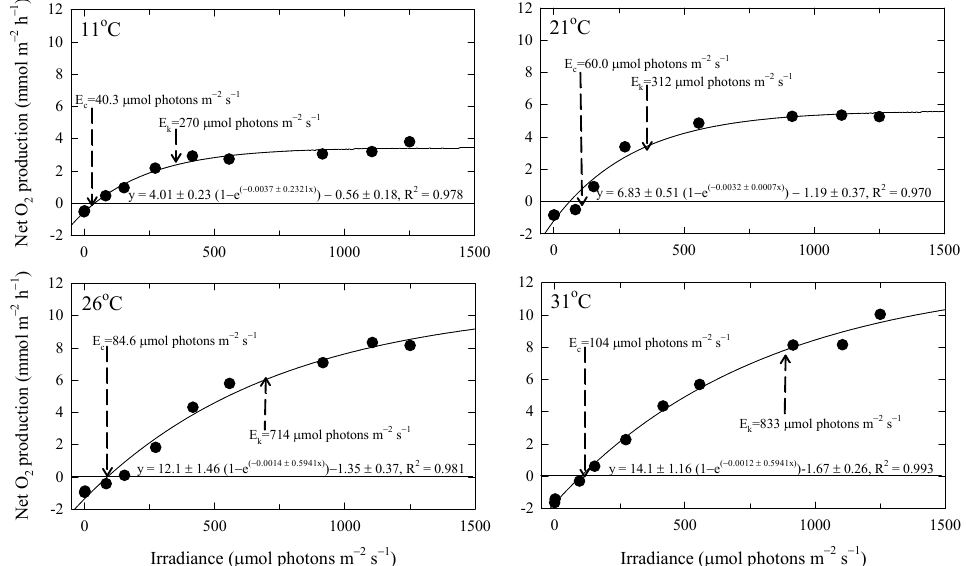
Figure 4. Net O 2 production–irradiance relationships of Pneophyllum fragile at 11–31°C. The solid lines represent the curve fit of the equation P(E) = P max [1 − exp(– α E d /P max )] + R d , where R d is the O 2 respiration rate. E k is the saturation irradiance, which was calculated as E k = P max / α . E c is the compensation irradiance, which is the irradiance at P(E) =